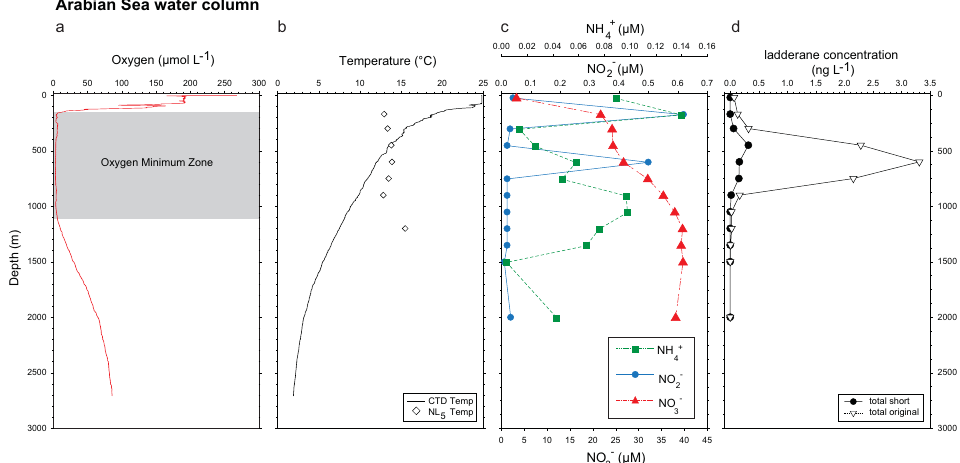
Fig. 4. Arabian Sea water column depth profiles of (a) dissolved oxygen concentrations (b) CTD measured temperature and NL 5 temperature (open lozenges) derived from water column particulate matter, (c) NH + concentrations, and (d) concentrations of ladderane fatty acids (original: open triangles; short chain: filled circles). Samples were taken during R/V Pelagia cruise 64PE301. Oxygen and temperature CTD data are from Pitcher et al. (2011), and original ladderane fatty acid data are from Rush et al.